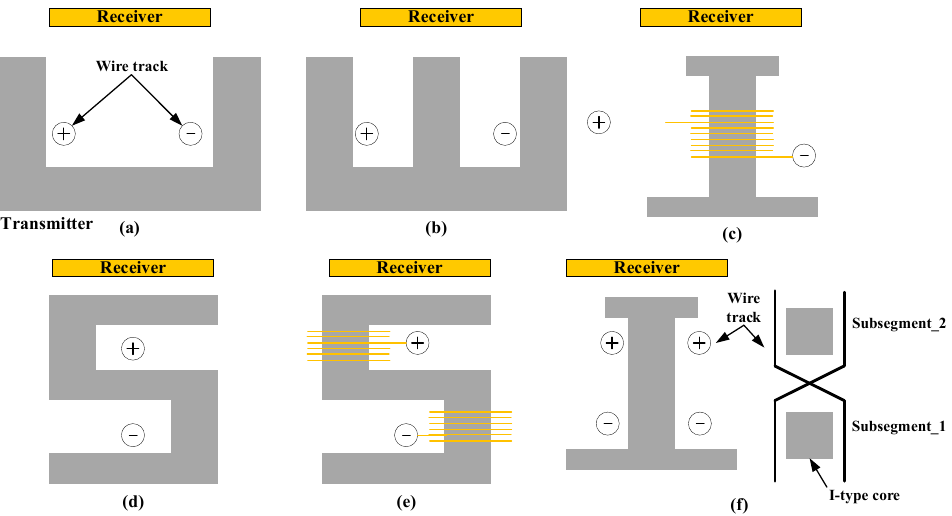
Figure 3. Components of DIPT system with single long coil track.